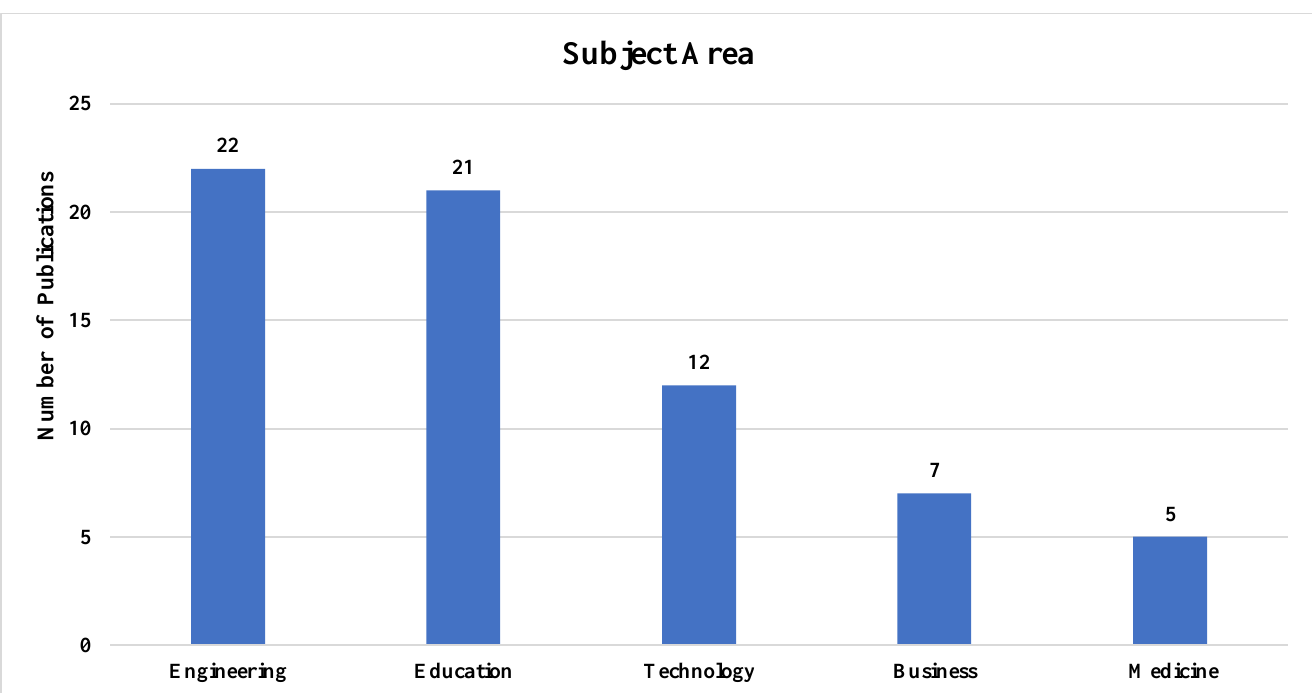
Figure 4. Number of publications according to the retraction reasons